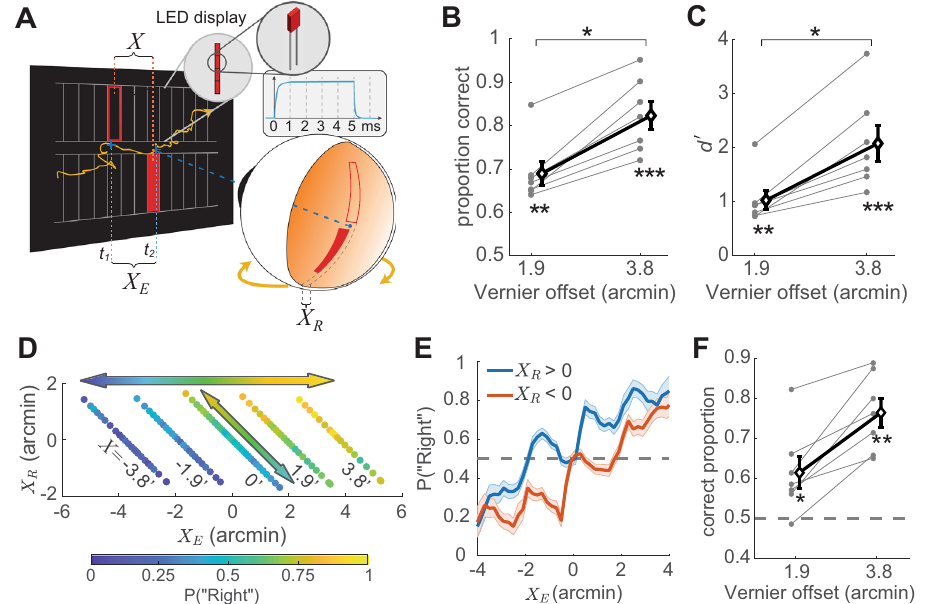
Fig.2|Controllingforvisualcues.A AcustomLEDdisplaydevelopedspeci fi cally for this study. This display, an array of 110×8 LEDs, each covering 1.9 0 on the horizontal meridian, was designed to provide no persistence and no background luminance. The insertshowsthe time-course of activityof one of theLEDswiththe brief exposures used in our experiments, measured with a high-speed photocell. B – F Performance measured with 5 ms exposures ( N =7 subjects). Both B proportions of correct responses and C the discriminability index improved as the Verniergapincreased(* p =7.21×10 − 4 in B and1.65×10 − 3 in C ;paired two-tailed t-tests) and were signi fi cantly above chance ( B : ** p =4.5×10 − 4 , *** p =5×10 − 5 ; C : Fig. 1H, I, with diamonds representing mean values±SEM across subjects. D Prob- abilityof “ Right ” responsesasafunctionofboththeeyedisplacementinatrial( X E )